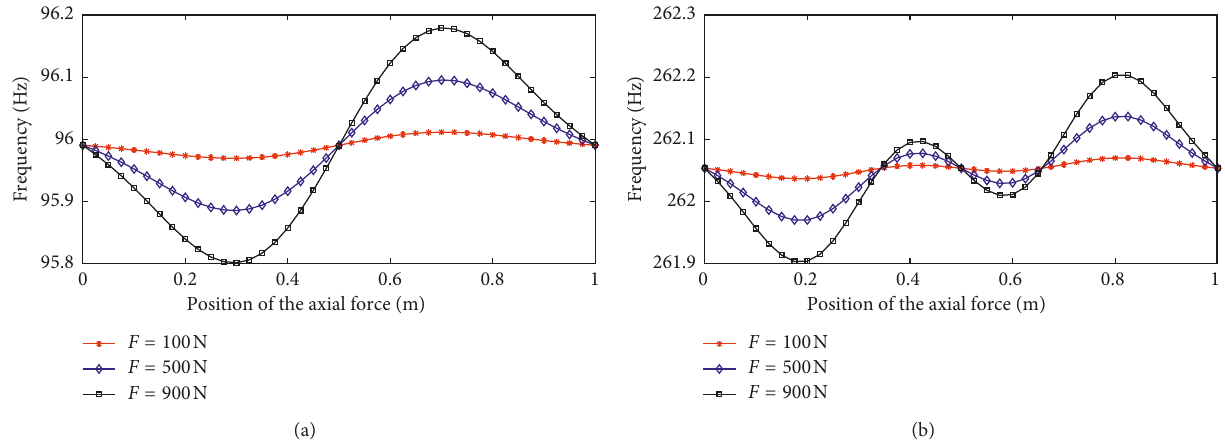
Figure 7: Influence of the location and amplitude of the axial force on natural frequencies of the ball screw. (a) First-order natural frequency. (b) Second-order natural frequency.